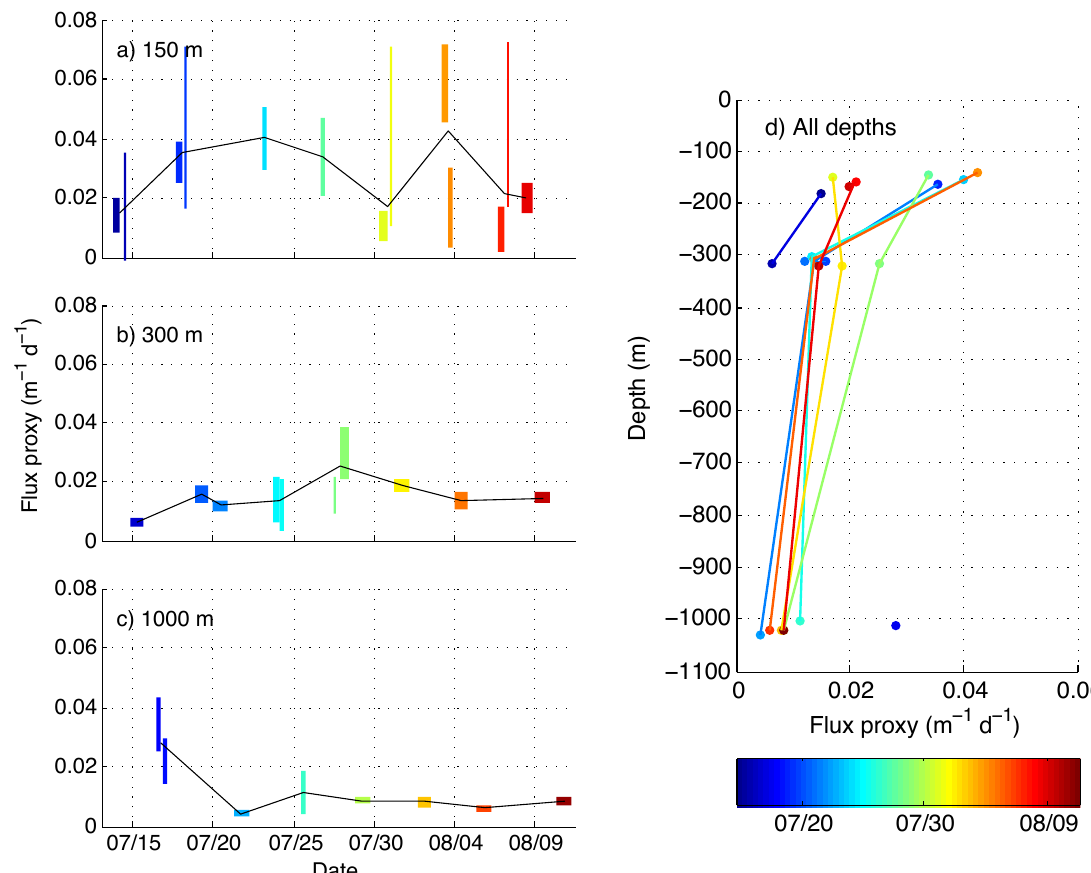
Fig. 8. Depth-resolved flux proxy from float B5. (a–c) Time series of flux measured at 150, 300, and 1000m. Black lines are drawn through weighted mean flux values for each profile cycle. Colored bars show temporal extent (width) and fitting uncertainty (height) of best-fit segments. (d) Profile-cycle mean flux proxy data organized into 3-day profiles. Color scale corresponds to date and applies to all